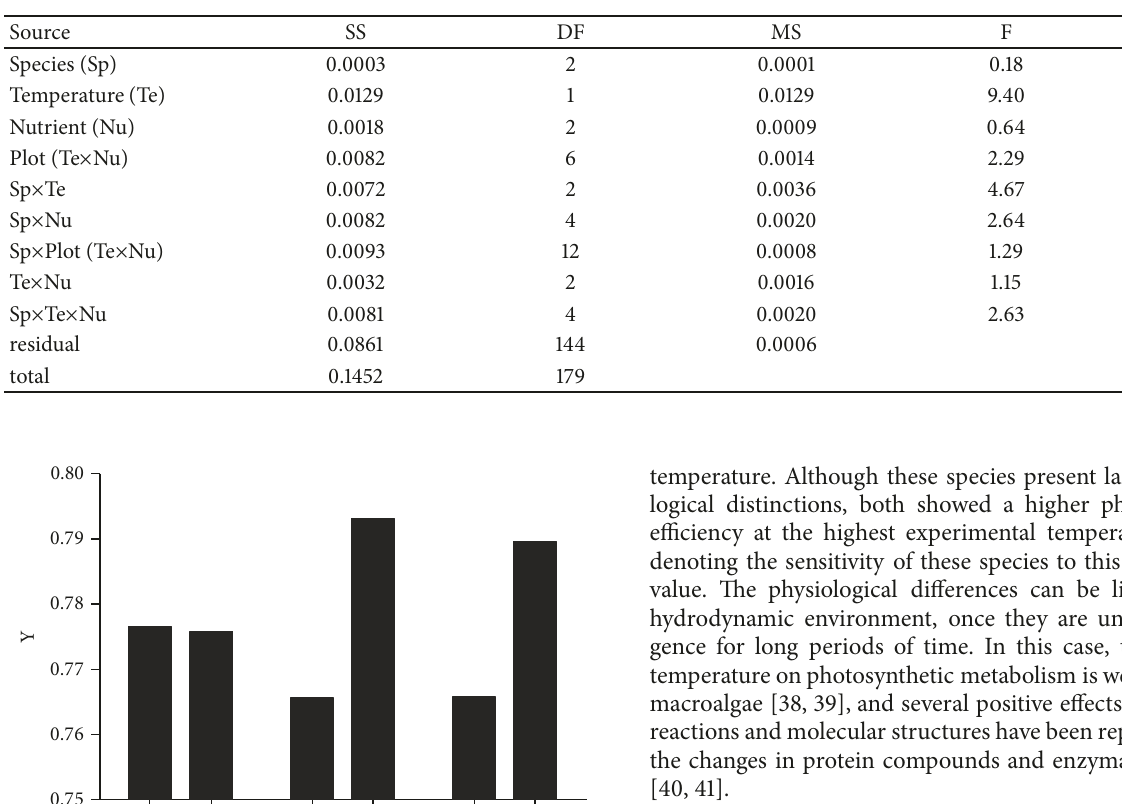
Table 1: Four-way analyses of variance of the photosynthetic capacities (based on the effective quantum yield of the PSII measurements) of three species of Ulva (orthogonal, fixed) that were incubated under different nutrient (orthogonal, fixed, three levels) and temperature (orthogonal, fixed, two levels) conditions. Plot: Erlenmeyer flasks where individuals were incubated (random and nested in the interaction of factors 1 and 2, two levels) . SS is sums of squares; DF is degrees freedom; MS is mean of square and P-value < 0.05 .